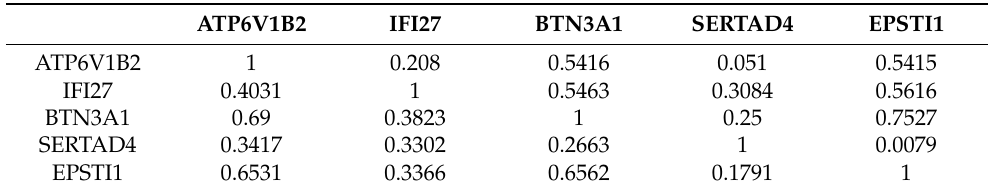
Table 8. Pairwise correlation coefficients: The upper triangle is for the first dataset, and the lower triangle is for the second dataset.